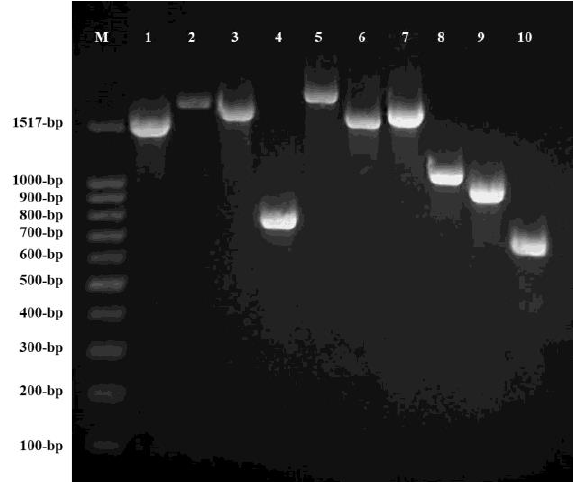
Figure 1. Electrophoresis results of polymerase chain reaction (PCR) products in Escherichia coli ATCC 25922 on 0.8% agarose gel. M: Molecular weight. Lines 1 to 10: PCR products of murA (1542 bp), glpT (1785 bp), uhpT (1667 bp), uhpA (771 bp), ptsI (1908 bp) , cyaA1 (1559 bp), cyaA2 (1648 bp), nfsA (1036 bp), nfsB (923 bp), and ribE (634 bp),